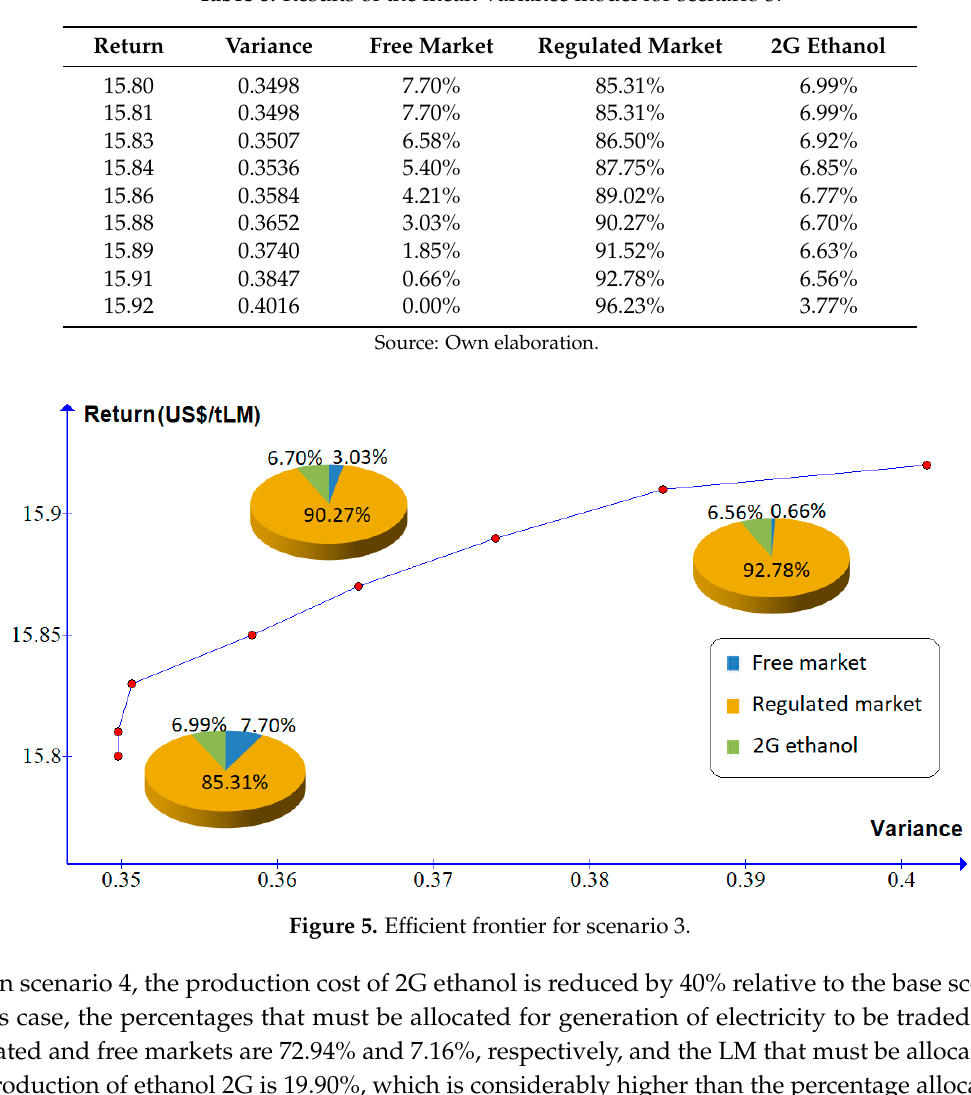
Table 8. Results of the mean-variance model for scenario 3.